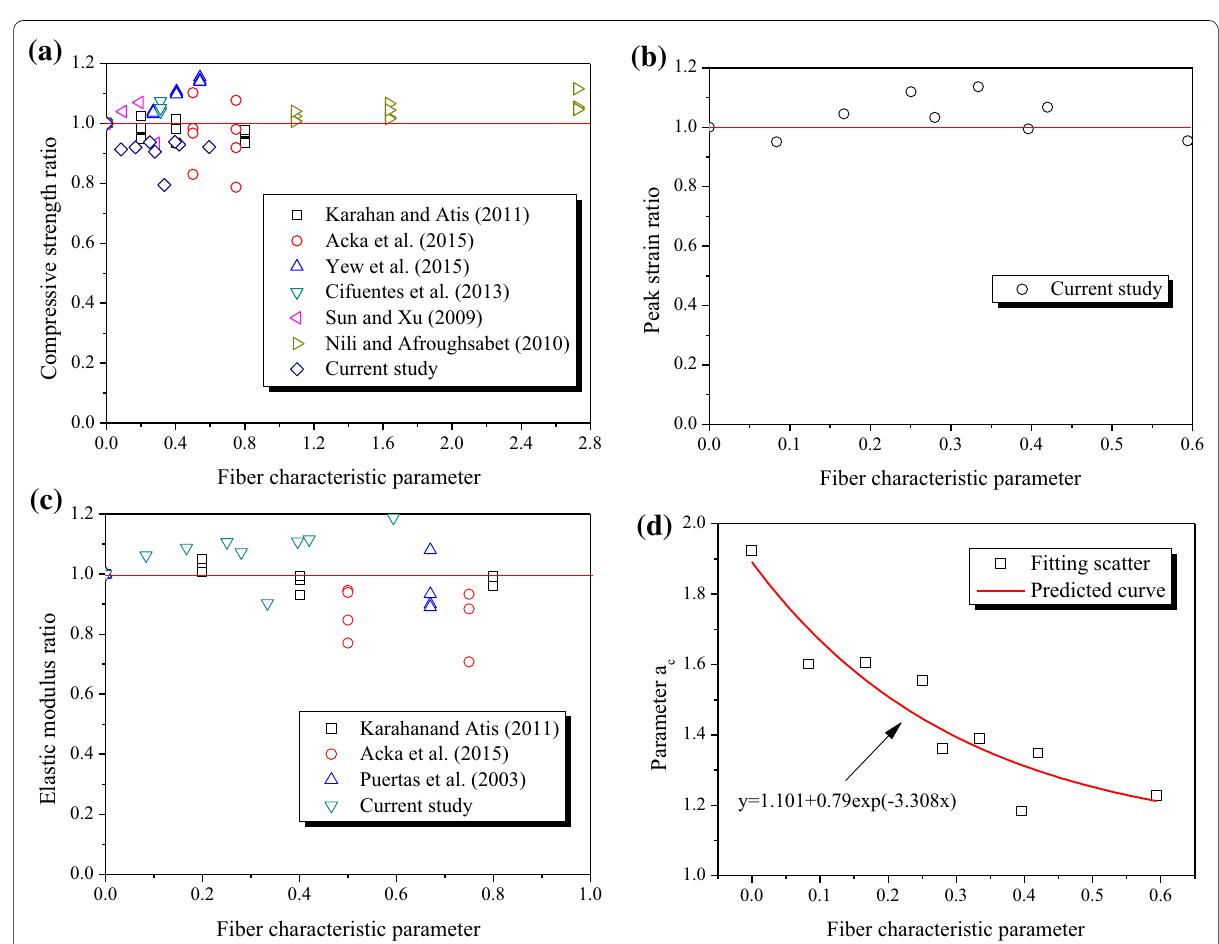
Fig. 18 Comparison results between experimental and predicted results. a Peak strength. b Peak strain. c Elastic modulus. d Parameter α c (Akca et al. 2015; Delassus et al. 2012; Puertas et al. 2003; Sun and Xu 2009; Yew et al.